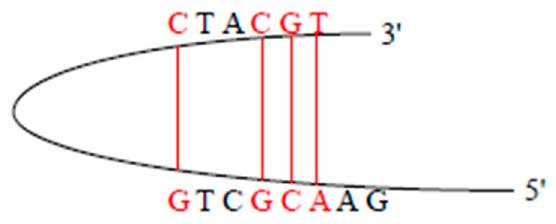
Figure 2. The card structure.